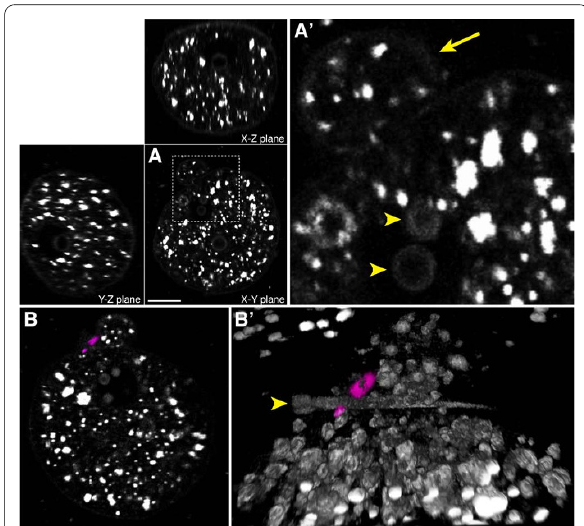
Figure 1 HGM reveals sub-cellular detail in the living mouse zy- gote . (A) THG image volume of a zygote, showing the high-resolution optical sectioning capability of the HGM. Various high-contrast globu- lar structures are visible in the cytoplasm. In addition, the plasma mem- brane and nucleoli are also visible. (A') high- magnification view of the boxed region in (A) showing details of the nucleolar signal (arrowhead) and the second polar body (arrow). (B) Optical section of SHG and THG signal from a just fertilized embryo. SHG signal (in magenta) is gener- ated by the spindle apparatus of the forming second polar body. (B') Opacity rendering of 3D image data. SHG signal from the spindle is in magenta while THG signal is in grey. A non-fertilizing spermatid is visi- ble outside the zygote (arrowhead). Scale bar in (A) represents 20 μm for (A), 6 μm for (A'), 13.7 μm for (B) and 7.3 μm for